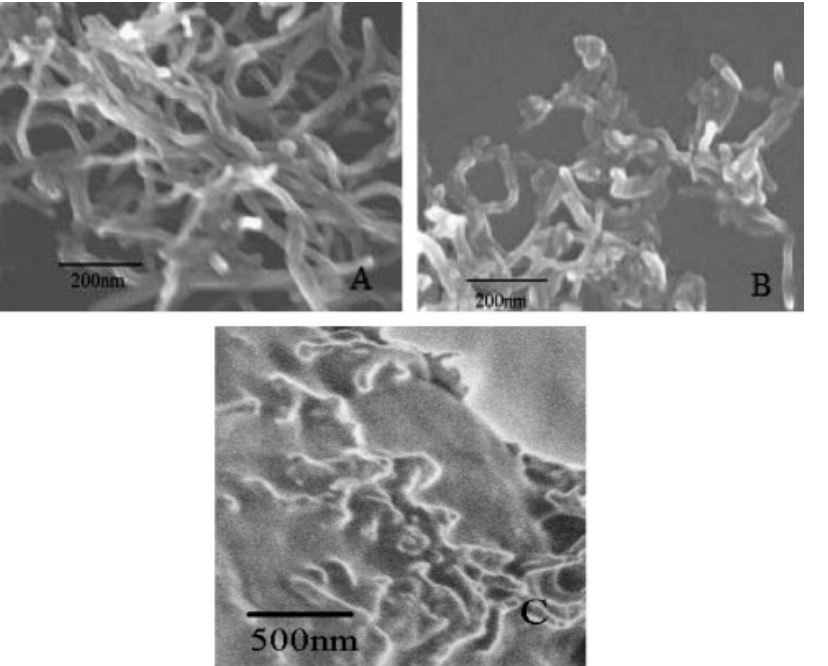
Figure 6. SEM images of palmitic acid/CNT NEPCM: ( A ) pristine CNTs, ( B ) treated CNTs, and ( C ) palmitic acid containing treated CNTs. (Reprinted with permission from ref. [23]. Copyright 2010 Solar Energy).